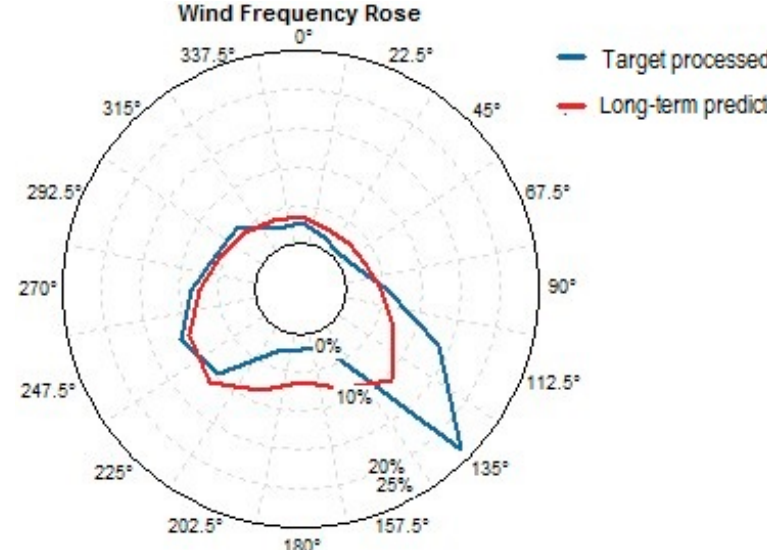
Figure 12. Long-term predicted wind direction.